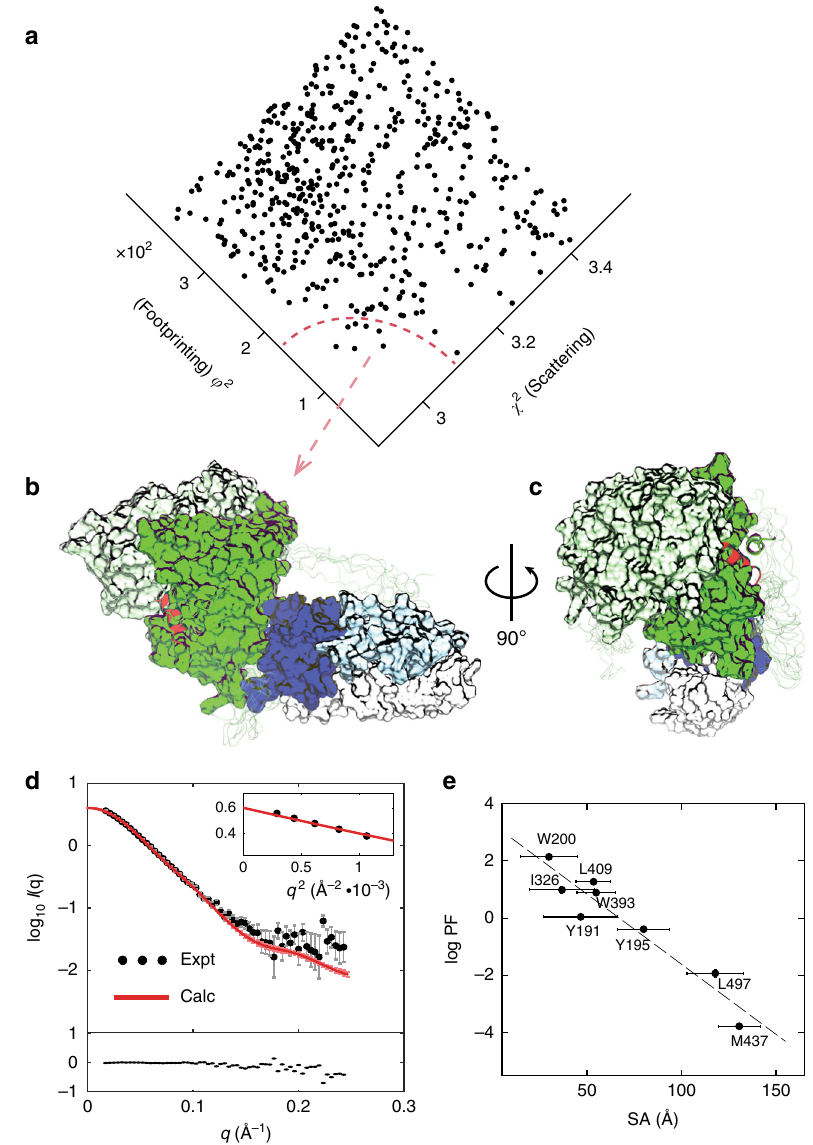
Fig. 2 Overall architecture of the hER α homodimer revealed by data integration. a Fitting against experimental data. The fi t of computationally generated conformations (dot) is simultaneously assessed against hydroxyl radical protein footprinting ( φ 2 ) and small-angle X-ray scattering ( χ 2 ). Lower χ 2 and φ 2 values are better in fi tting. The best- fi t ensemble structures lie at the bottom corner of the fi t plot, below the red dashed line. b Ensemble of best- fi t hER α structures. It contains both LBD monomers (light/dark green) and DBD monomers (light/dark blue). The C-terminal helix H12 of the LBD is in red, and ERE – DNA is in gray. The LBD – DBD connecting loops are shown as light green ribbons. The structure models (within the red circle) are within 3 Å C α - RMSD of the best- fi t structure. c A rotated view of the best- fi t hER α structures. d Goodness of fi t to measured SAXS data. Theoretical SAXS data were the ensemble average of the set of hER α structures above. The scattering intensity, log 10 I ( q ), is plotted as a function of the scattering angle ( q ). The goodness of fi t χ 2 = 1.2. Inserted is the Guinier plot with a linear fi t, yielding the radius of gyration R g = 38.0 ± 0.3 Å. The bottom graph shows residuals from subtraction between calculated and experimental pro fi les. A total of six scattering images were used and standard deviations were indicated. e Goodness of fi t to footprinting data. Measured footprinting protection factors (logPF) are plotted against average accessible surface areas (SA) derived from the ensemble structures. Linear correlation coef fi cient is ρ = − 0.95. A total of seven structures were used for ensemble calculations and standard deviations were